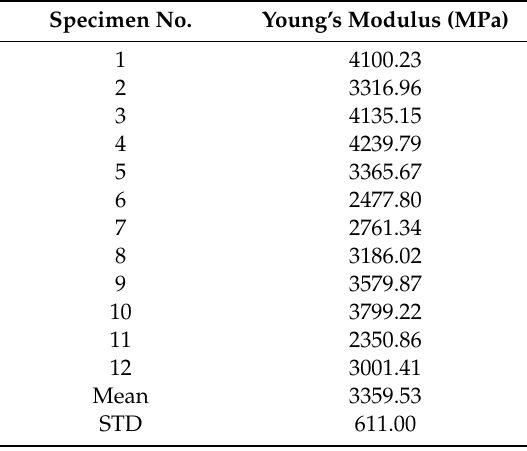
Table 7. Young’s Modulus of the 12